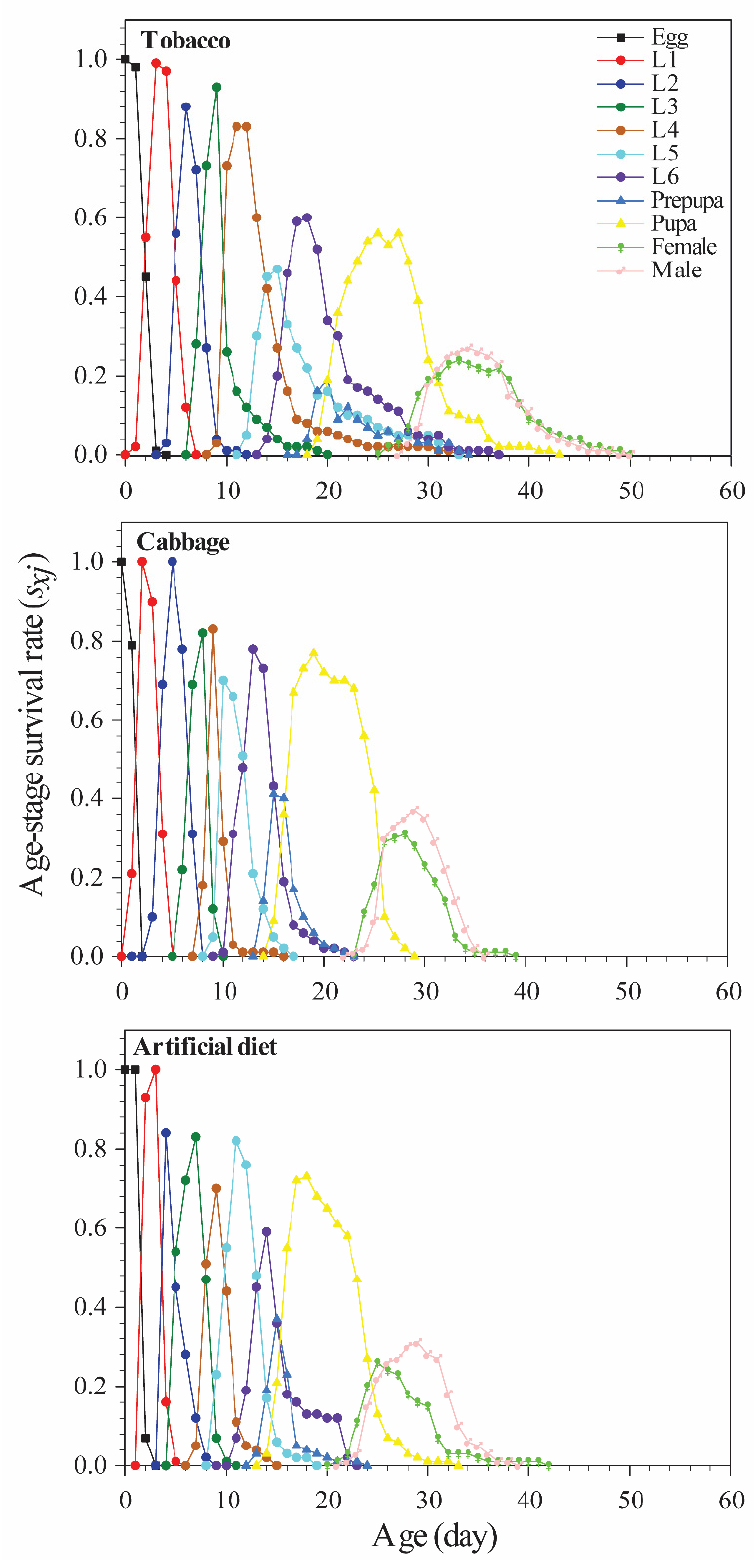
Figure 1. Age-stage specific survival rate ( s xj ) of Spodoptera litura reared on different diets.